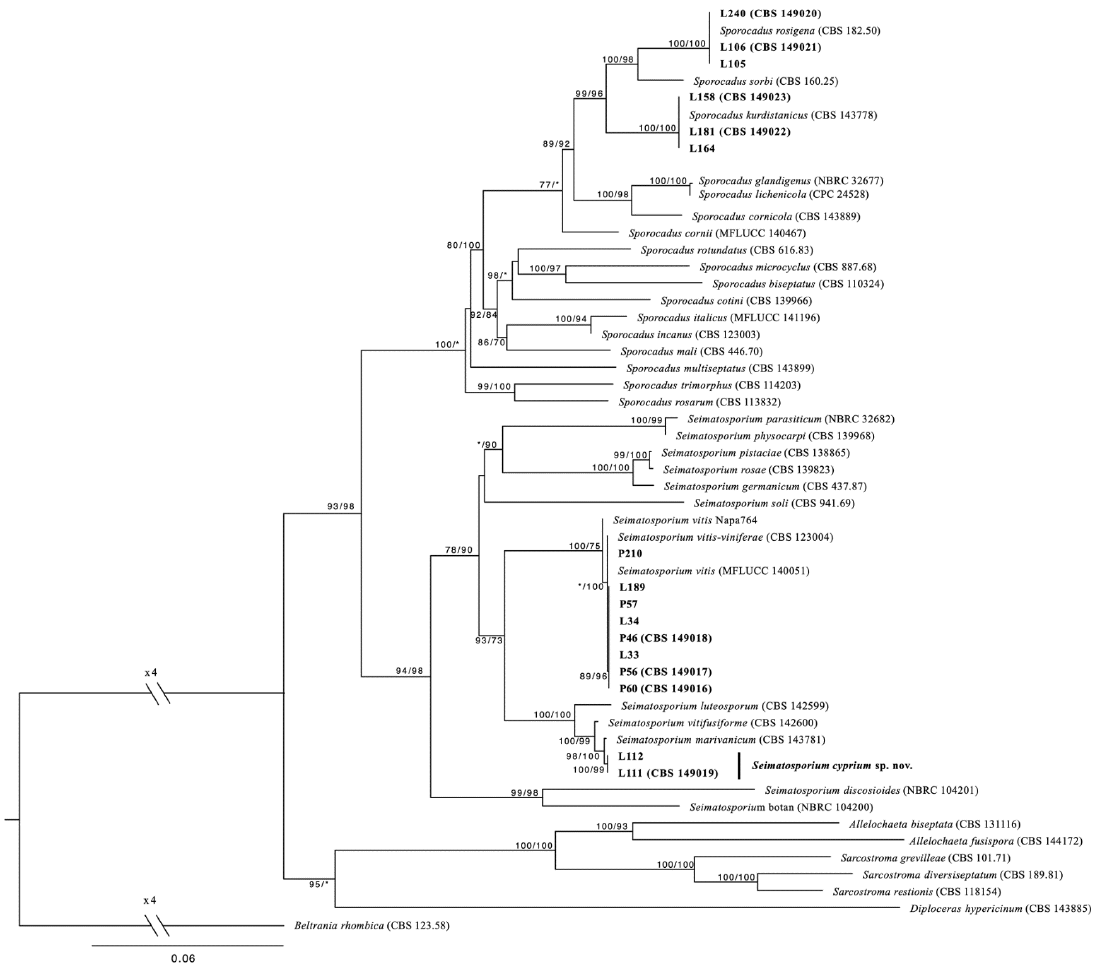
Figure 1. Phylogenetic tree (log-likelihood: − 15,895.468) resulting from the combined analysis of ITS, LSU, tub2 , and tef1 sequence data from 54 Sporocadaceae . Numbers represent maximum-likelihood and maximum-parsimony bootstrap values, respectively. Values represented by an asterisk were less than 70%. Scale bar represents the expected number of substitutions per site. The tree was rooted to Beltrania rhombica (CBS 123.58).